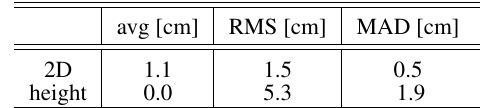
Table 3. Comparison between point clouds generated with close-range photogrammetry and ToF camera